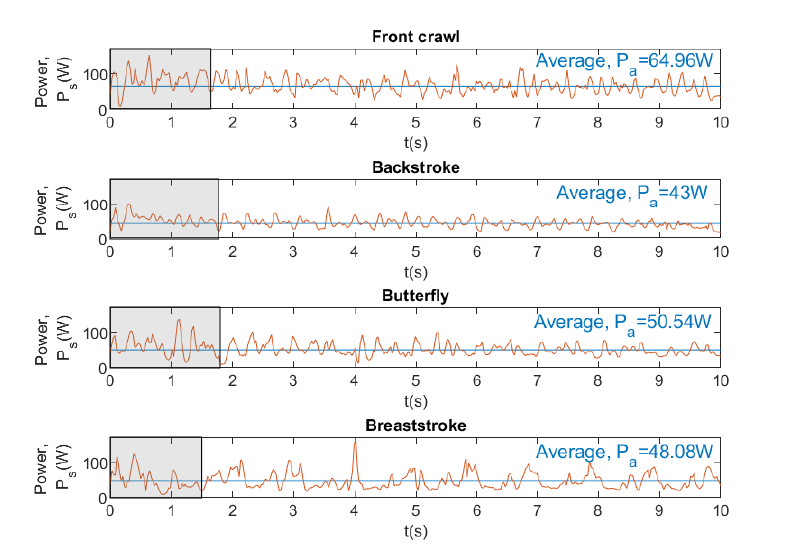
Figure 16. Instantaneous and average power for four swimming strokes. Brake force = 68.41